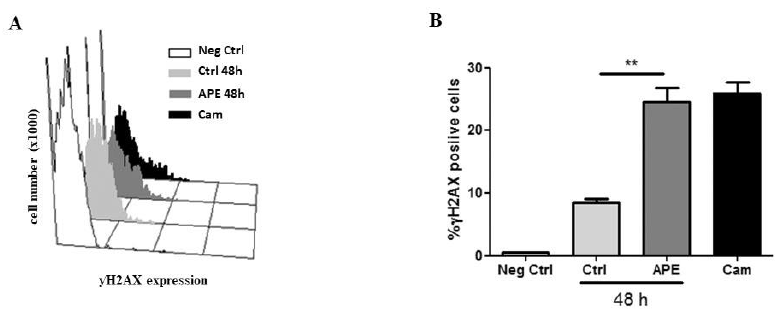
Figure 8. ( A ) Distribution diagram of p- γ H2AX expression vs. cell number ( × 1000). ( B ) Percentage of p- γ H2AX positive cells in GB8 cells after 100 µ M APE treatment. Camptothecin (5 µ M) was used as a positive control. (t-test; APE 48 h vs. Crtl ** p < 0.01). The data are the average ± SEM of three independent experiments.